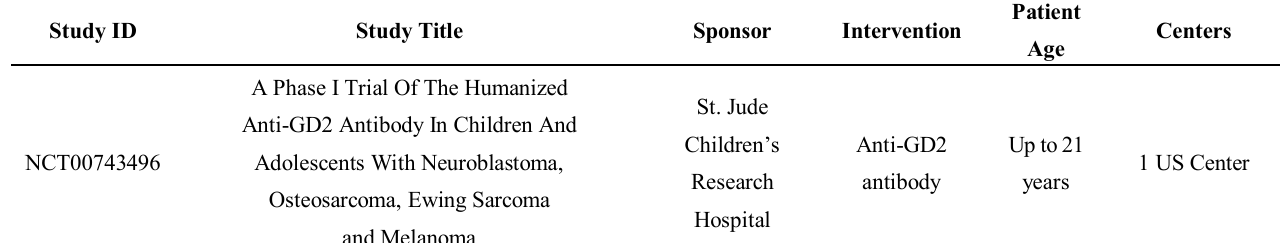
Table 1. Clinical Trials in Adolescent Melanoma on